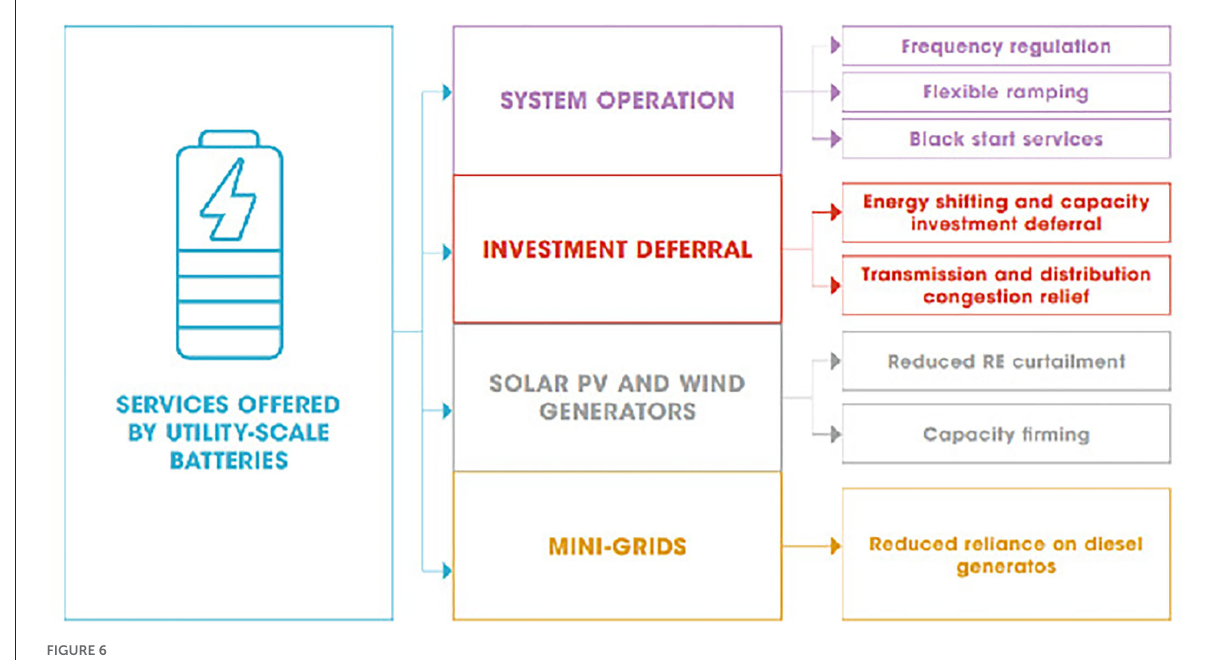
FIGURE6 Services offer by utility scale batteries (Irena, 2019c).